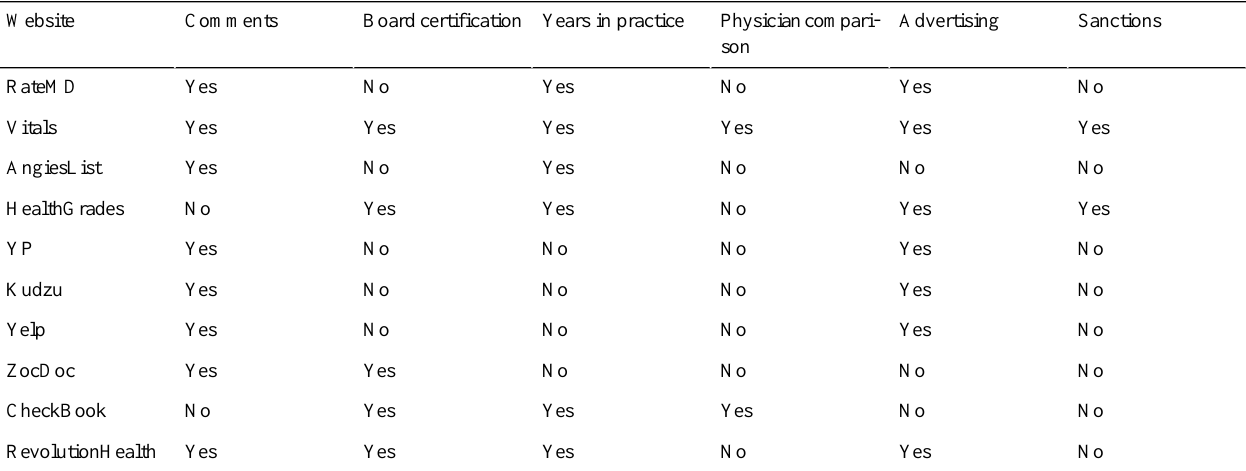
SanctionsAdvertisingPhysician compari- sonYears in practiceBoard certificationCommentsWebsite